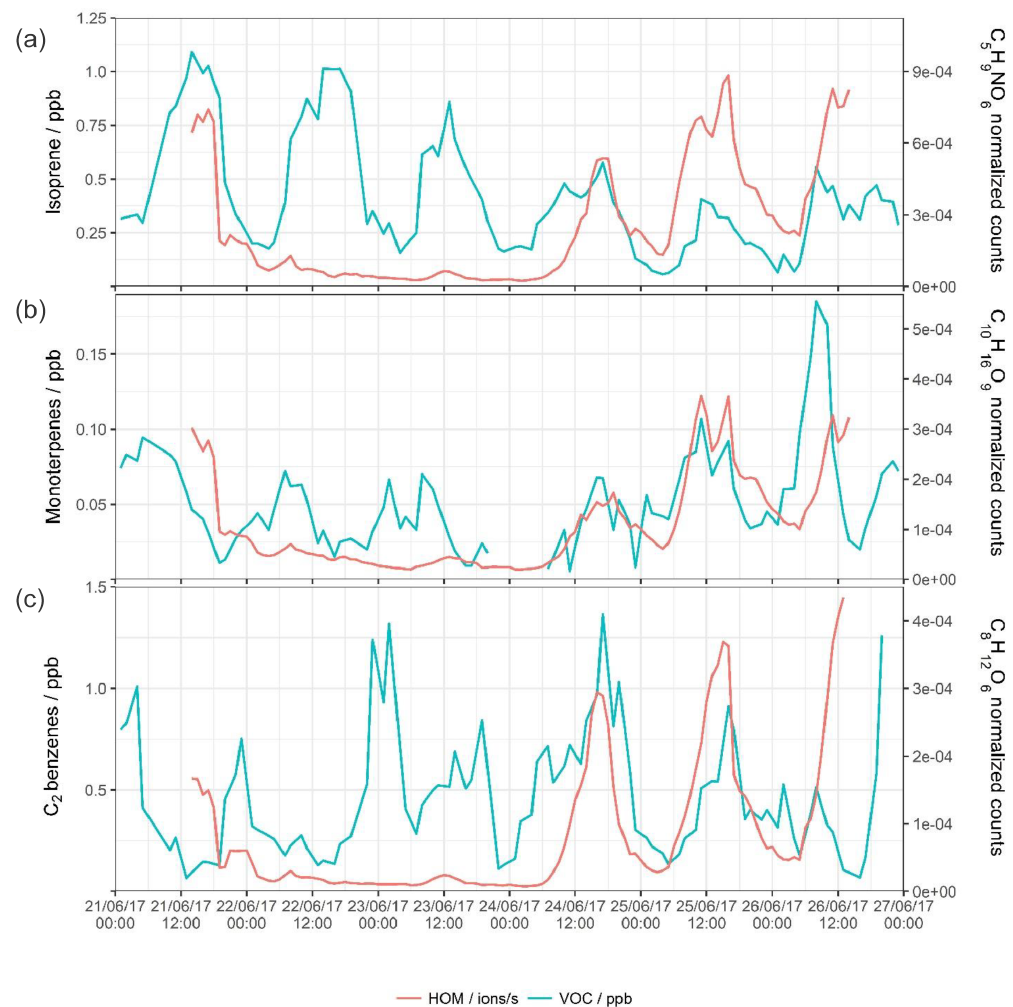
Figure 4. Time series for the whole sampling campaign for the concentrations of (left axis) VOCs as measured by PTR-ToF-MS and (right axis) a selected HOM product associated with that